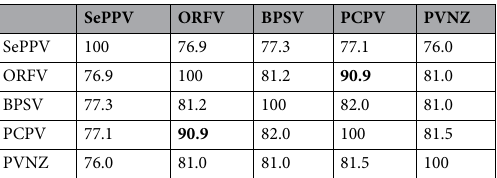
Table 2. Percentage nucleotide identity between the full-length genome sequences within the genus parapoxvirus. SePPV (KY382358); ORFV (AY386264.1); PVNZ (NC_025963.1); BPSV (NC_005337.1); PCPV